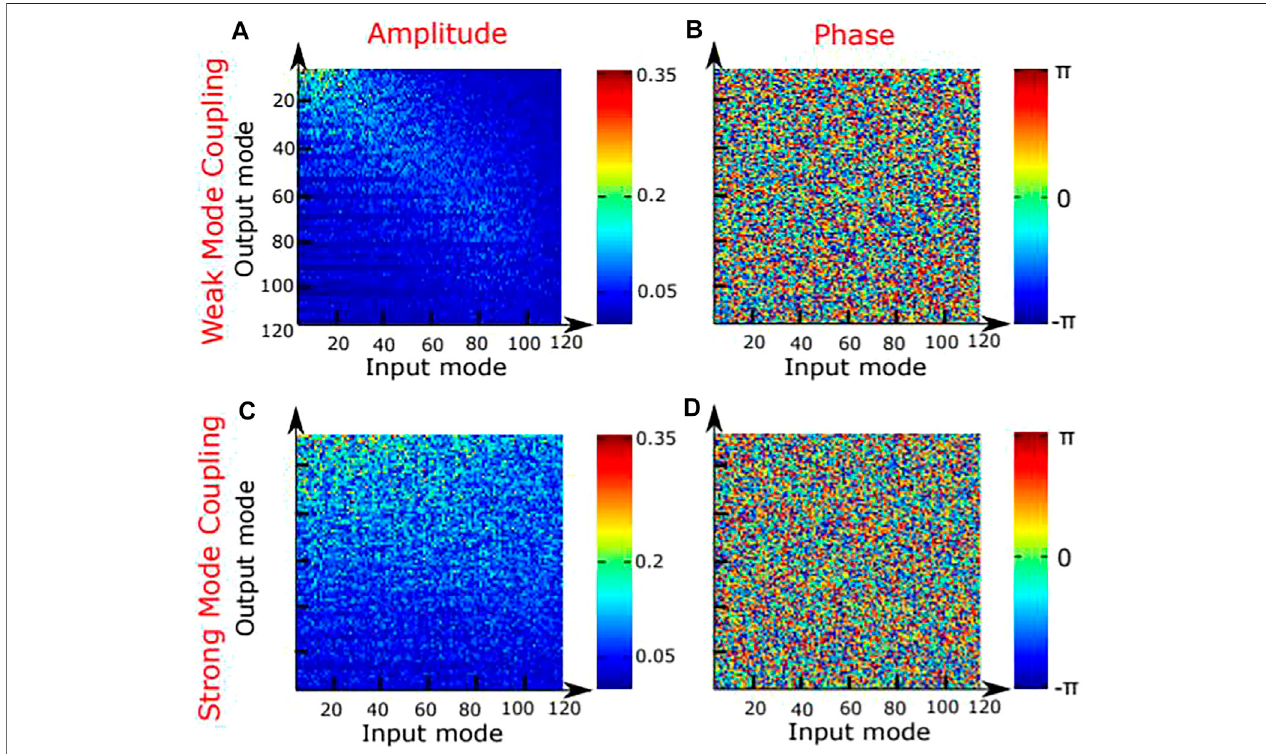
FIGURE 3 | Input and output – amplitude and phase for a fi ber in the presence of weak and strong mode coupling.